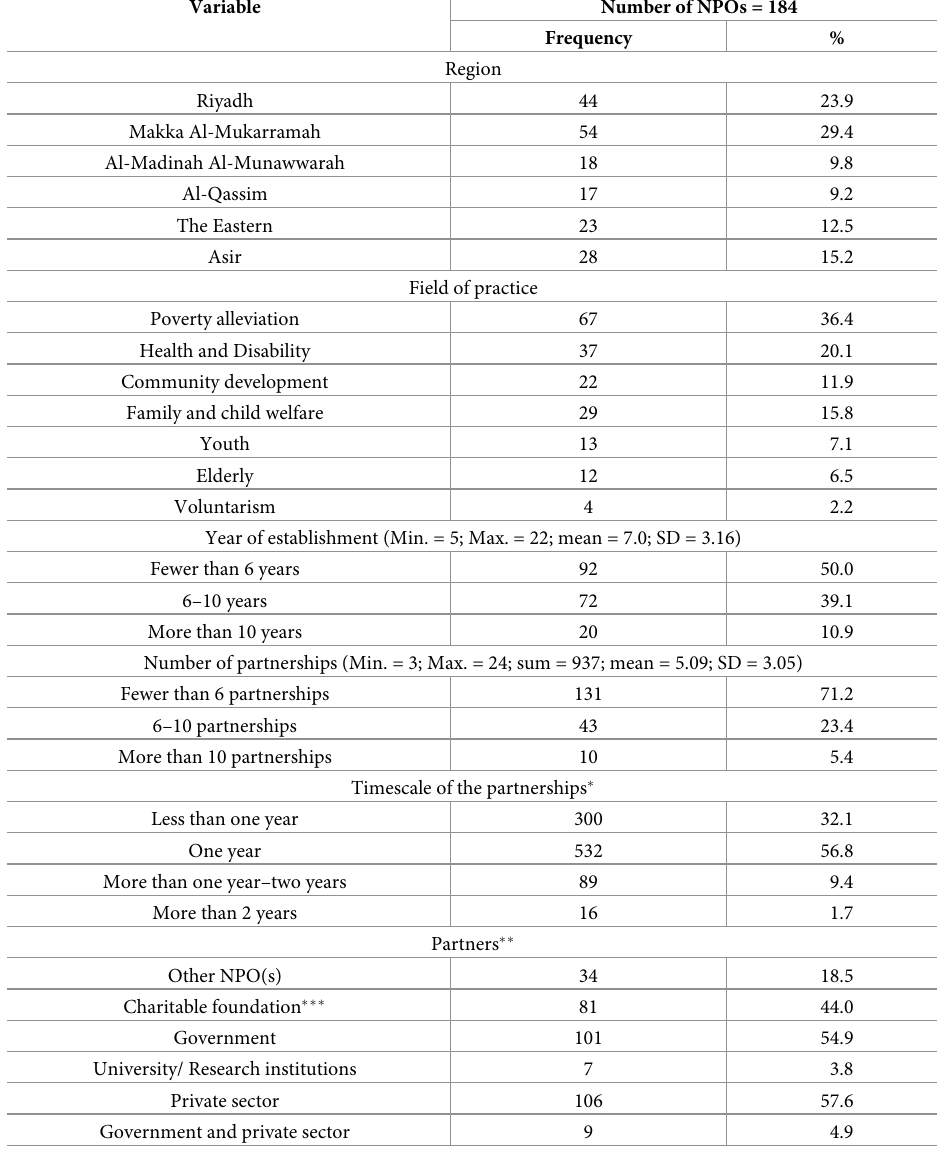
Table 1. Profile of participant nonprofit